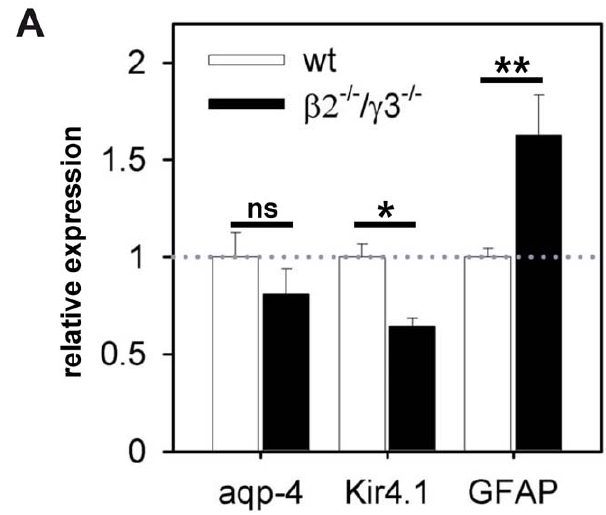
Figure 3. Relative expression of Kir4.1, aquaporin-4 and GFAP mRNA in wild-type and b 2 2 / 2 / c 3 2 / 2 retina. Values are normalized to GAPDH expression and were set as 1 for wild-types (n=9 animals; white bars). In retinal tissue of b 2 2 / 2 / c 3 2 / 2 (n=7 animals; black bars) the expression of Kir4.1 mRNA is significantly reduced (* P , 0.05), while aquaporin-4 mRNA only shows a non-significant tendency to lower levels (ns: not significant; P=0.597). In contrast, the expression level of GFAP, a marker for retinal gliosis, is upregulated (**P ,